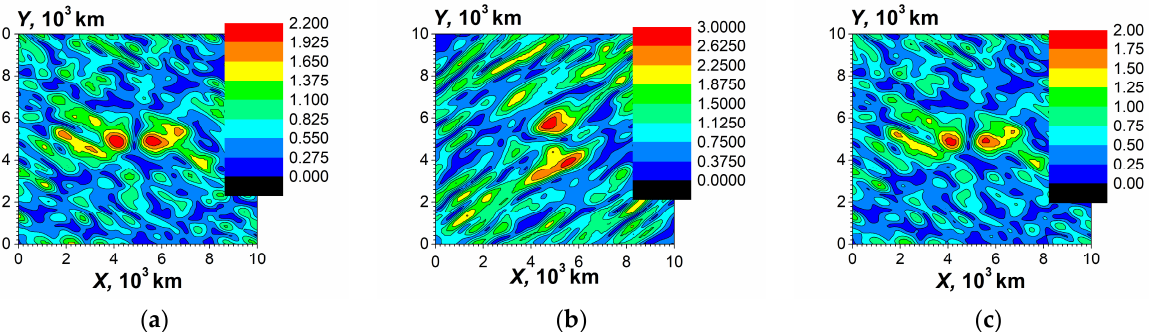
Figure 12. Distributions of the electric field components (in mV/m) in the ionosphere F- layer at the height z = 200 km. The dynamic simulations, the case of closed geomagnetic field lines. The frequency is ω = 0.025 s − 1 . Part ( a ) is |E x (x,y)| , ( b ) is |E y (x,y)| , ( c ) is |E z (x,y)| . It is increased inclination angle compared with Figure 9, the inclination angle is θ i = 40°. The total vertical distance of the simulation is L z = 2000 km.